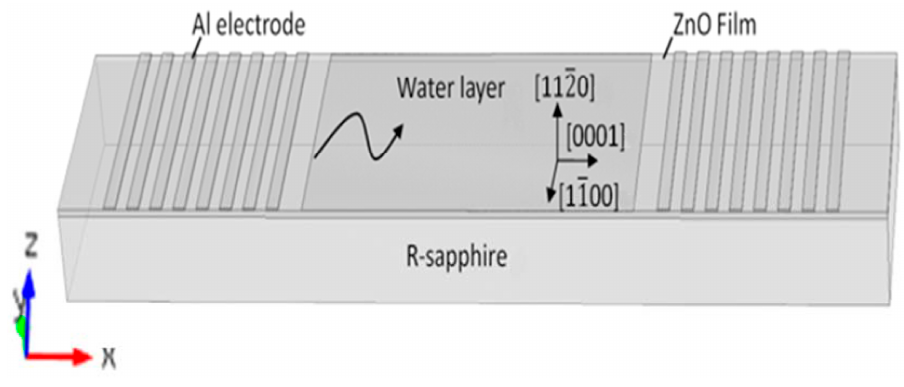
Figure 1. Schematic diagram of the Rayleigh wave sensor.